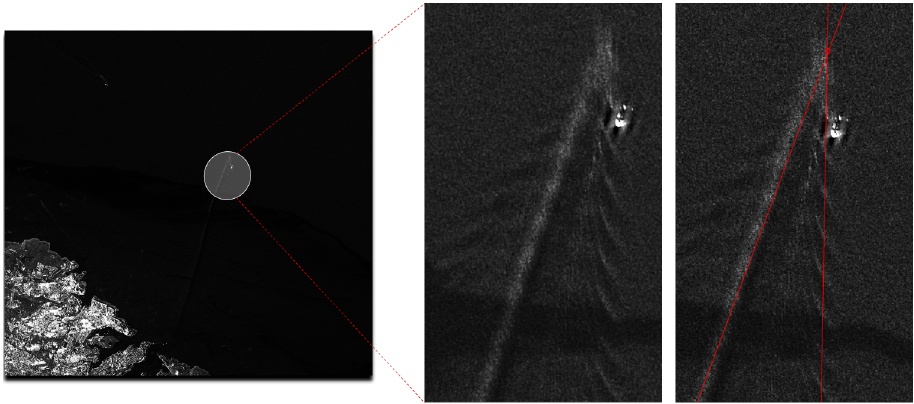
Figure 7. Wake pattern detection.